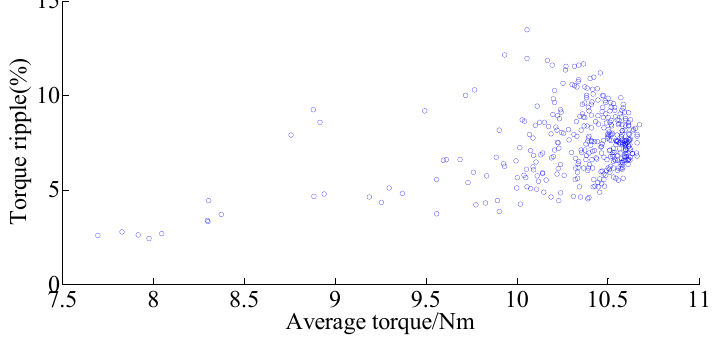
Figure 4. Optimization results of average torque and torque ripple.